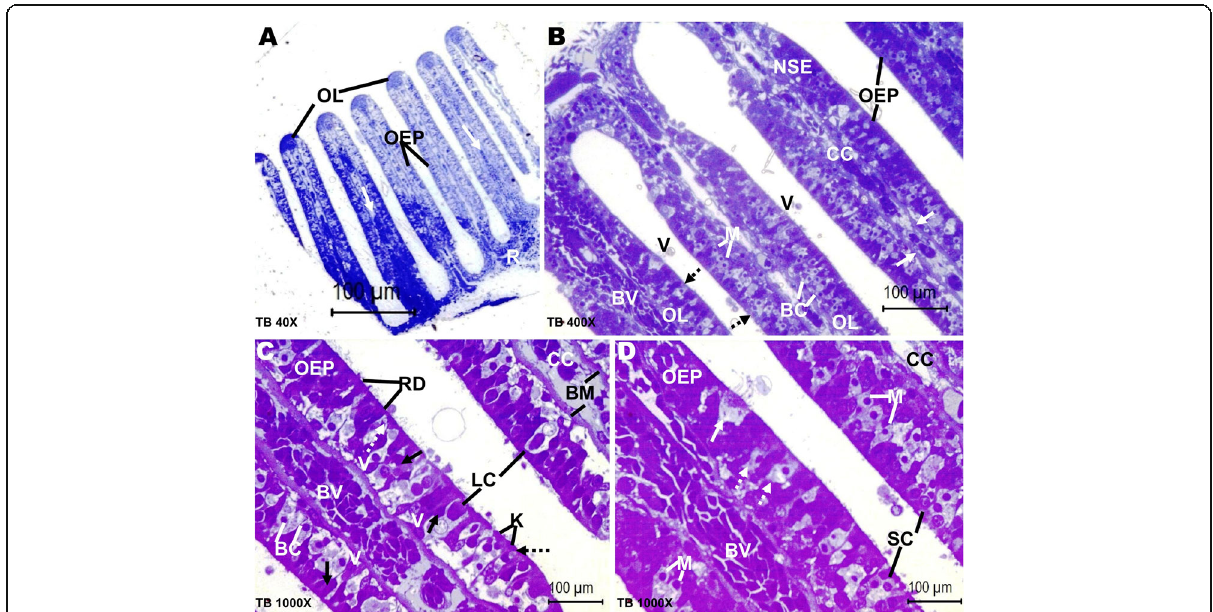
Fig. 3 Photomicrographs of the semithin sections of the olfactory lamella in E. vacha stained with toluidine blue (TB). A Transverse section of olfactory lamella (OL) proliferated from raphe (R) shows olfactory epithelium (OEP) and central core (arrows). B OL shows nonsensory epithelium (NSE) containing ciliated supporting cells (arrow heads), labyrinth cells (broken arrows), mast cells (M), and basal cells (BC). CC supported with blood vessels (BV) segregates from OEP by basement membrane (solid arrows). C Magnified sensory OEP illustrates primary receptor cells (solid arrows) synaptic connection with secondary receptor cells (arrow heads), microvillar cells (broken arrows), and rod cells (RD). Note presence of BV in CC, which is distinguished from OEP by BM. K for olfactory knob (K), BC for basal cells, and LC indicates labyrinth cells. D Higher magnification of nonsensory OEP portrayed with mast cells (M), labyrinth cells (broken arrows), ciliated supporting cell (solid arrow), and nonciliated supporting cells (SC). CC contains